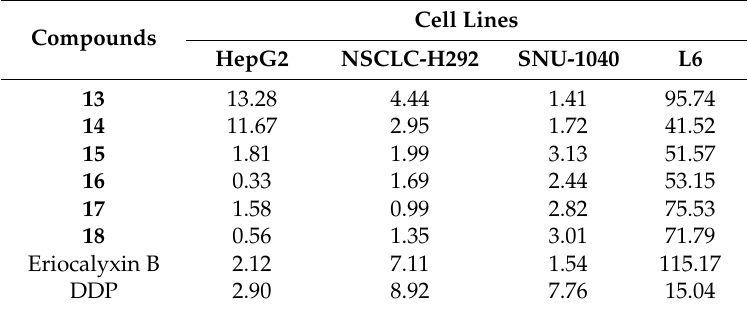
Table 1. In vitro cytotoxic activities of compounds 13 – 18 (IC 50 , µ M) a,b